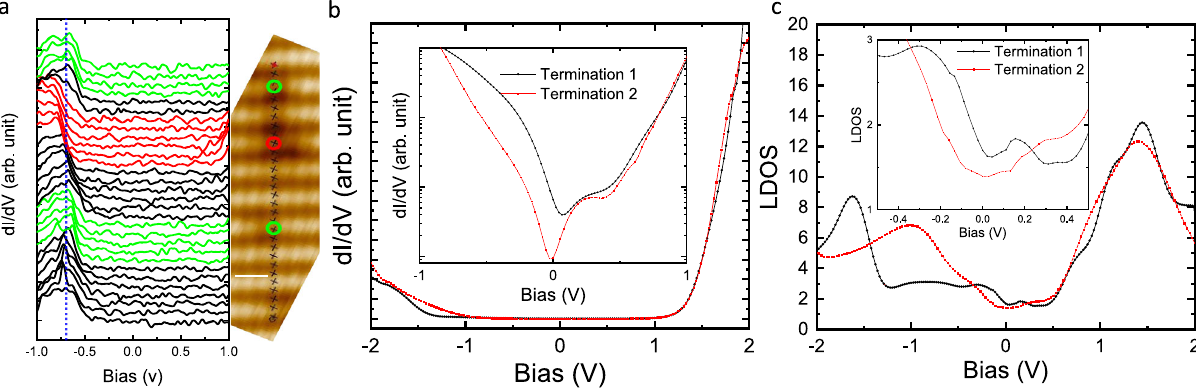
Fig. 4 Average electronic behavior of two terminations. a STS spectra across two type-A defects (green spectra), one type-B defect (red spectra), and surrounding defect-free area (black spectra). The corresponding morphology image with the defects positions and spectra positions is included on the right (set point: − 1 V, 100 pA, the scale bars represent 1 nm). b Average d I /d V spectra normalized to same set point (2 V, 100 pA) for T1 and T2. Inset: data replotted in a semi-logarithmic scale. c LDOS calculated as d I /d V / I / V from ( a ). Inset: zoom-in data near V = circles are copied and pasted without any position adjustment to Fig. 3d. In Fig. 3d, all the green circles have a defect (type-A) in it, but there is no defect in the majority of the red circles (11), with three exceptions (red circles with X); and there exists an un-circled defect nearby most of the red circles. This means that in-between Fig. 3c, d, 11 out of the 14 type-B defects are moved at least on atom position along the 2 × 1 stripes. In contrast, none of the 63 type-A defects is moved. Counted from STM images, there are about 5% type-A and 0.7 % type-B defects (per 1 × 1 surface unit cell). Shown in Fig. 3e is the local barrier height (LBH) image from the same area, the slight contrast difference between type-A and type-B defects suggests there exists some chemical composition difference surround these defects. Figure 4a displays the gradual change of the conductance (d I /d V ) spectra across two type-A defects (green spectra) and one type-B defect (red spectra) as indicated in the corresponding morphology image (right of Fig. 4a). Note that the electronic in fl uence of these defects is extensive as discussed below. Compared with the black spectra with their peak positions guided by a dotted line, the green spectra obviously show peak splitting, while the red spectra show peak shift to higher energies in the occupied state.